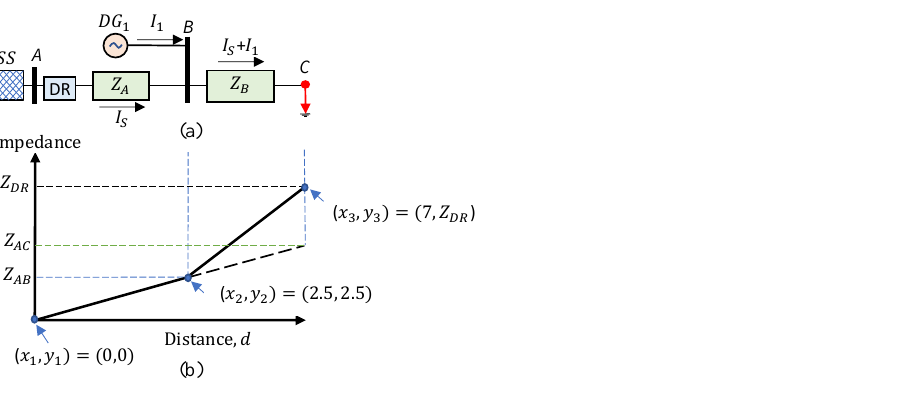
Figure 11. Infeed effect on distance protection: ( a ) radial distribution feeder with one DG; ( b ) impedance seen by DR at A